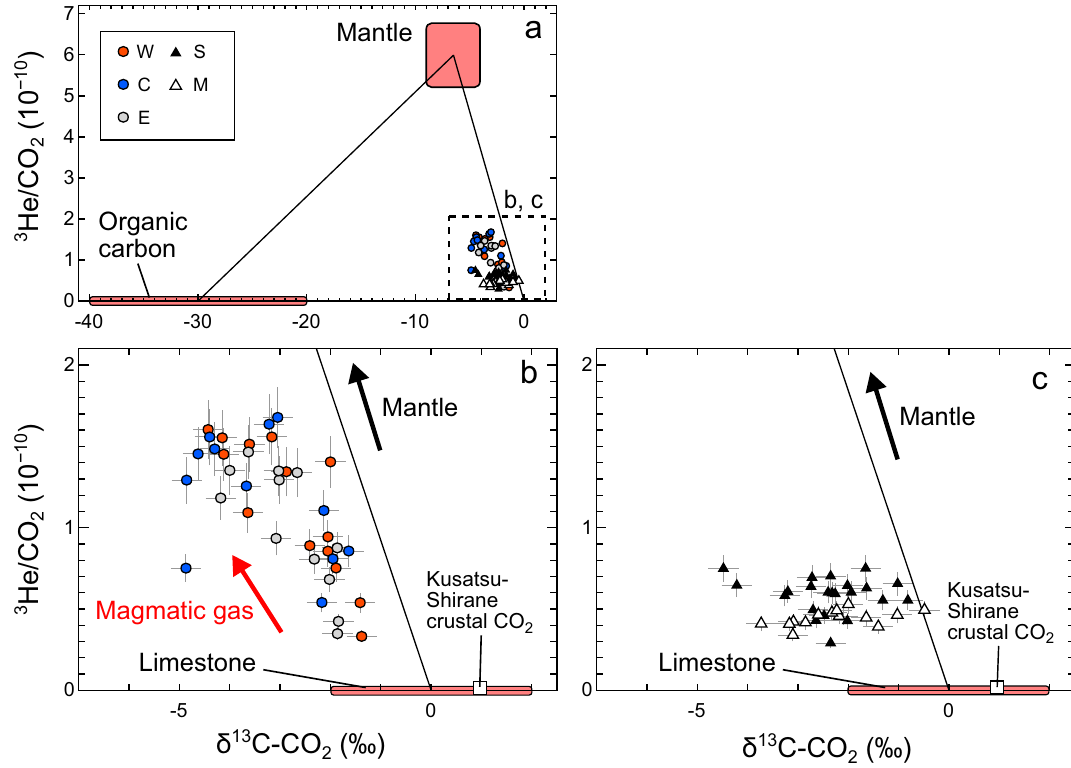
Figure 3. 3 He/CO 2 versus δ 13 C-CO 2 diagrams for the fumarolic gas samples. ( a ) Gas compositions for the W, C, and E fumaroles in the Kitagawa geothermal area and the Sesshogawara (S) and Manza (M) fumaroles. A dotted square indicates the areas of panels ( b ) and ( c ). ( b ) Gas compositions for the Kitagawa W, C, and E fumaroles. ( c ) Gas compositions for the S and M fumaroles. The mantle 3 He/CO 2 ratio of (5.99 ± 0.75) × 10 −10 is after ref. 30 . The ranges of δ 13 C-CO 2 values for mantle (− 4‰ to − 9‰), organic carbon (− 20‰ to − 40‰), and limestone (− 2‰ to 2‰) are after ref. 11 . The estimated δ 13 C-CO 2 value (1.1‰) for Kusatsu-Shirane crustal CO 2 10 is also shown. Black lines are the mixing lines between mantle composition and organic-derived CO 2 , and mantle composition and limestone-derived CO 2